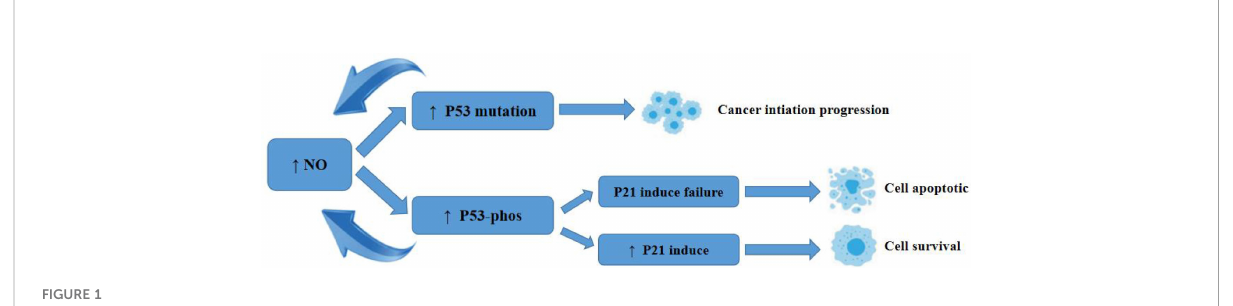
FIGURE 1 Schematic diagram of the mechanism of action of NO on